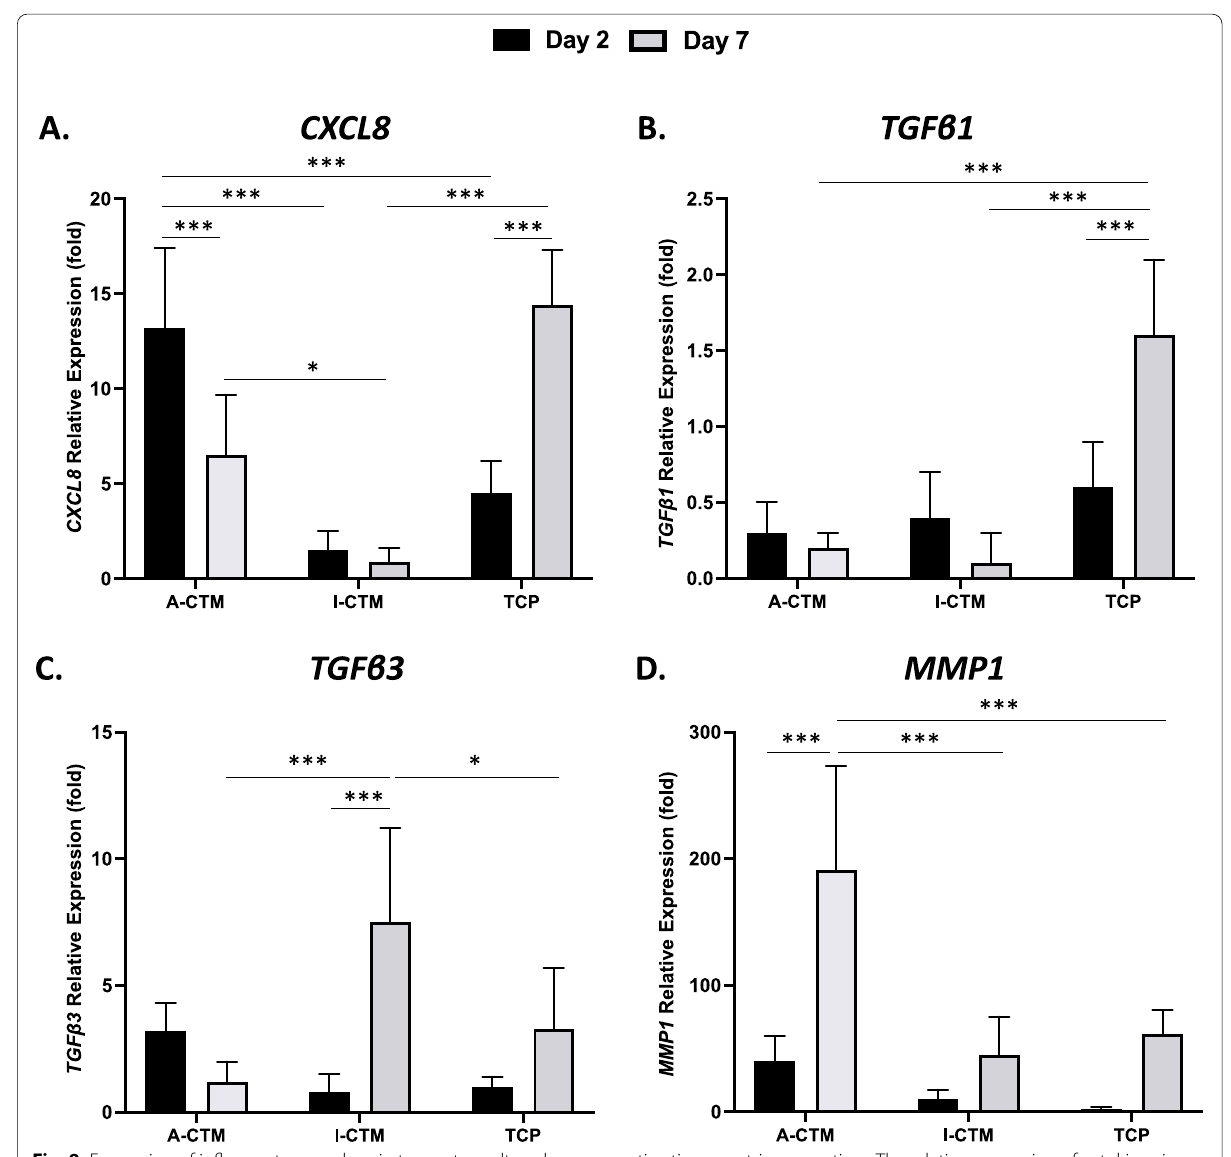
Fig. 8 Expression of inflammatory markers in tenocytes cultured on connective tissue matrices over time. The relative expression of cytokines in tenocytes cultured on A-CTM, I-CTM, and TCP for 2 days and 7 days is shown. The relative expression (fold) of CXCL8 ( A ), TGFβ1 ( B ), TGFβ3 ( C ), and MMP1 ( D ) was compared to the mRNA level in tenocytes on Day 0 (starting cells). Data shown are mean on TCP). * p < 0.05, ** p < 0.01 and *** p <